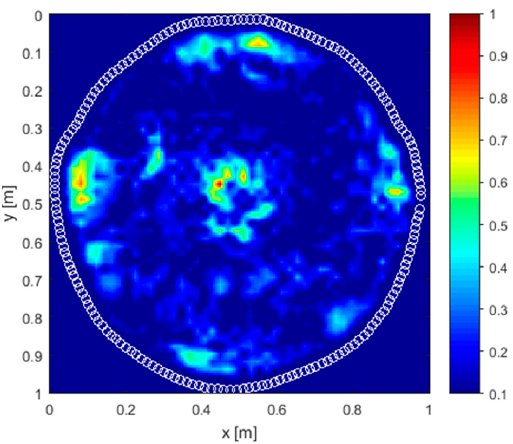
Figure 9. Radargrams of the simulations for the circular hardwood tree scenario. ( a ) Raw radargam; ( b ) processed radargram after the application of the pre-processing stage.